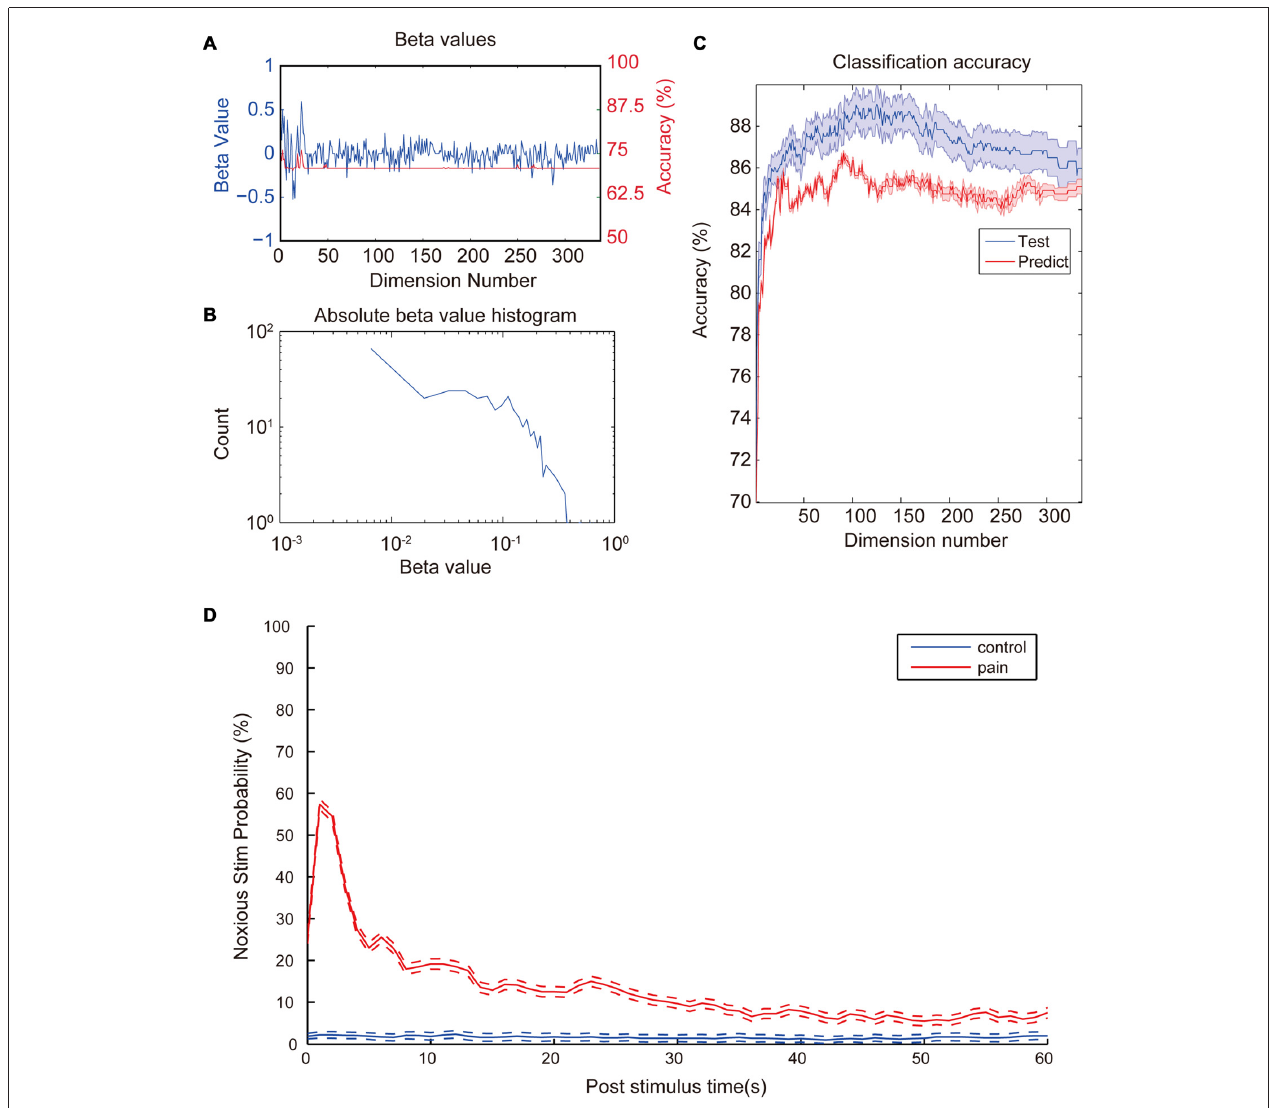
FIGURE 3 | Coefficient values and prediction rate of generalized linear models (GLMs). (A) β -values of the initial GLM classifier which trained with the whole dataset (Blue). Classification accuracy of GLMs trained with the corresponding LFP feature in the test set (Red). (B) Histogram of absolute β -values. Most features contribute little to the data classification. Only a few features contribute most to the classification. Distribution of coefficient values has a nearly log-normal distribution. (C) Prediction accuracy of the GLM models trained with different numbers of most contributing features. Training set (Blue) consists of 2962 laser trails from 12 rats and prediction set (Red) consists 296 trails from a separate animal. Accuracy was calculated based on a 10-fold cross-validation. Classification accuracy for the test set increases fast with input numbers of features at the beginning and slowly reaches a top accuracy with dimension numbers around 120. Then accuracy starts to drop slowly all the way to around 86%. Shaded area indicate standard error margin. (D) Averaged noxious laser stimulation probability vs. post-stimulus time. Rates were calculated from the most accurate GLM in the previous step. The blue line and the red line represent control stimulation and noxious stimulation, respectively. Dash lines indicate the standard error margin. Significant increase of pain prediction probability appears in a time window of 1 s to 2 s after noxious stimulation, indicating a robust feature of laser-induced pain. Control group kept a low value for the entire period and does not show any increase after the stimulation